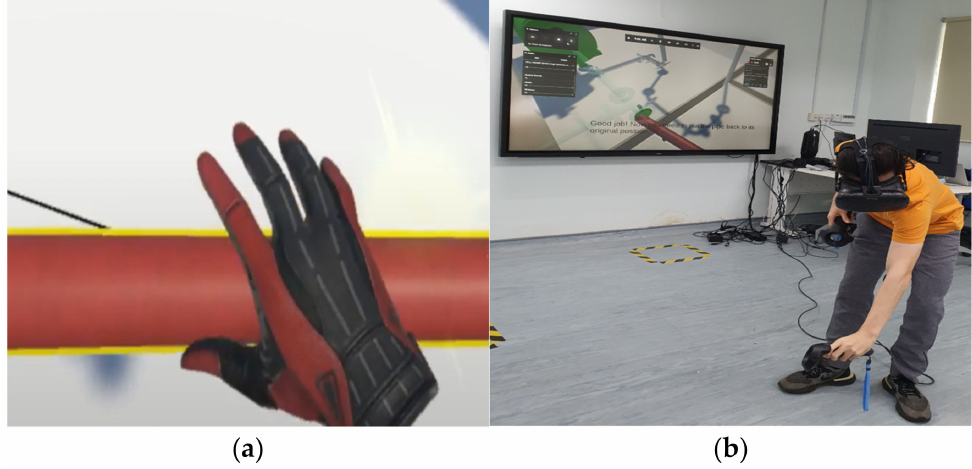
Figure 5. Contrived hands-on experience training scenario. ( a ) User replacing the piping system; ( b ) Contrived hands-on task from the real-world